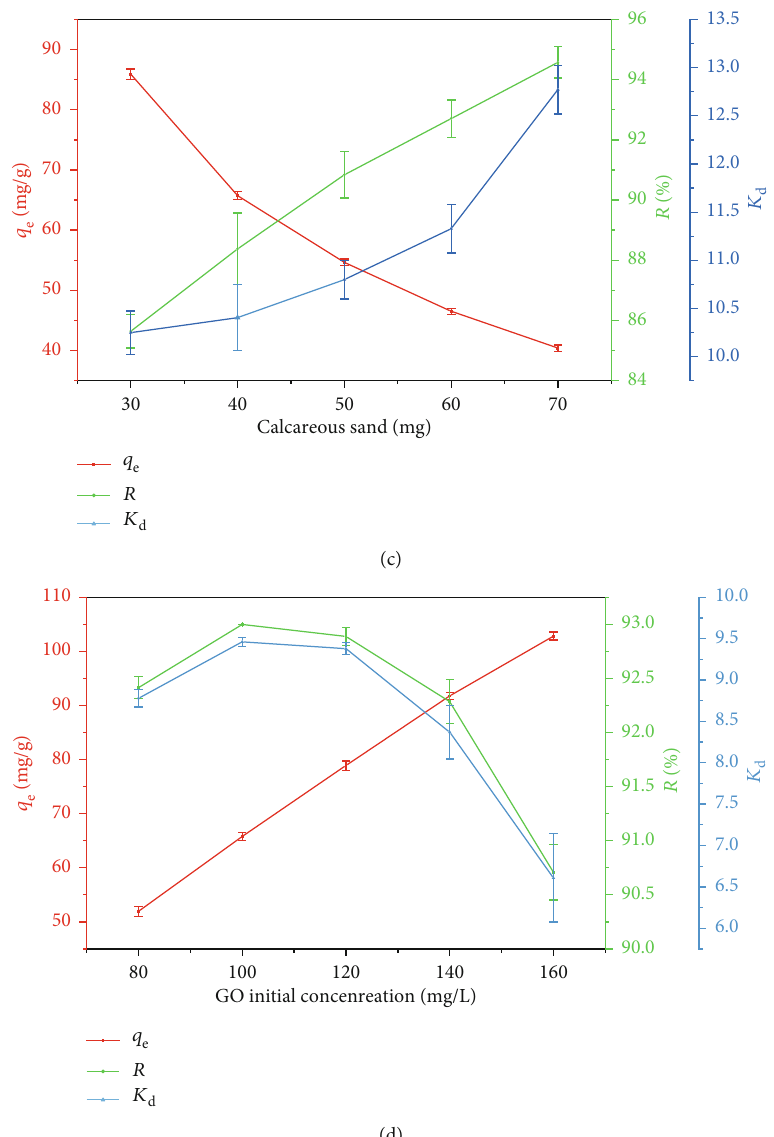
Figure 2: Adsorption of GO on calcareous (a) e ff ect of pH. (b) Zeta potentials of GO and calcareous sand/GO. (c) E ff ect of calcareous sand content. (d) GO initial